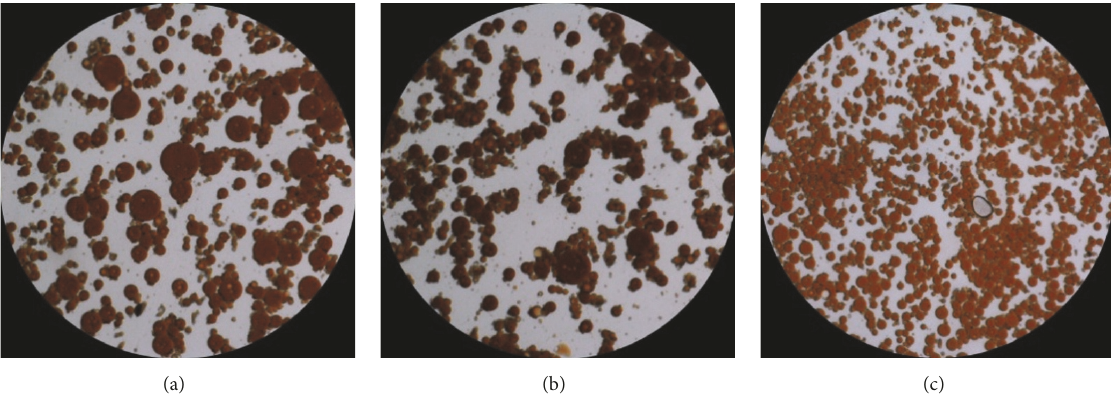
Figure 7: Micrographs of emulsions with different chemical agent: (a) 0.3 wt% surfactant + 2000 mg/L polymer; (b) 0.8 wt% Na 2 CO 3 + 2000 mg/L polymer; (c) 0.3 wt% surfactant + 0.6wt% Na 2 CO 3 + 2000 mg/L polymer.